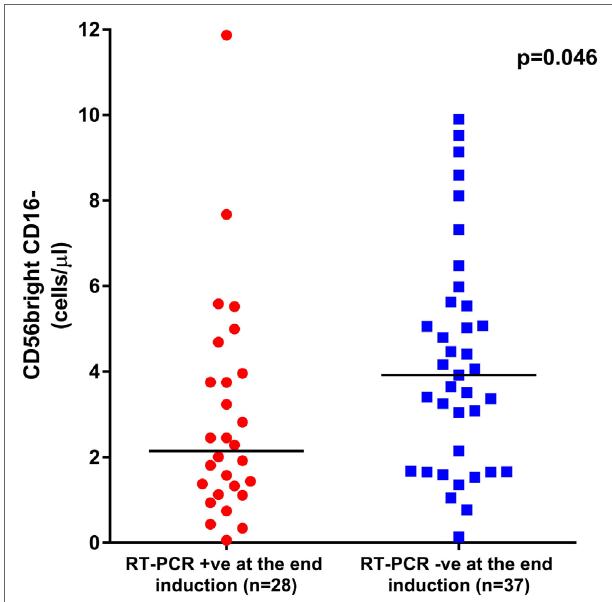
FigUre 7 | Graphs showing the impact of CD56 bright CD16 − subset recovery on clinical outcome. The median absolute counts of CD56 bright CD16 − immature subset was significantly lower in those patients who were RT-PCR positive at the end of induction ( n = 28) with a median of 2.15 cells/ μ l (range: 0.06–11.87 cells/ μ l) when compared with those who were RT-PCR negative ( n = 37) with a median of 3.92 cells/ μ l (range: 0.14–9.9 cells/ μ l, p = 0.046).